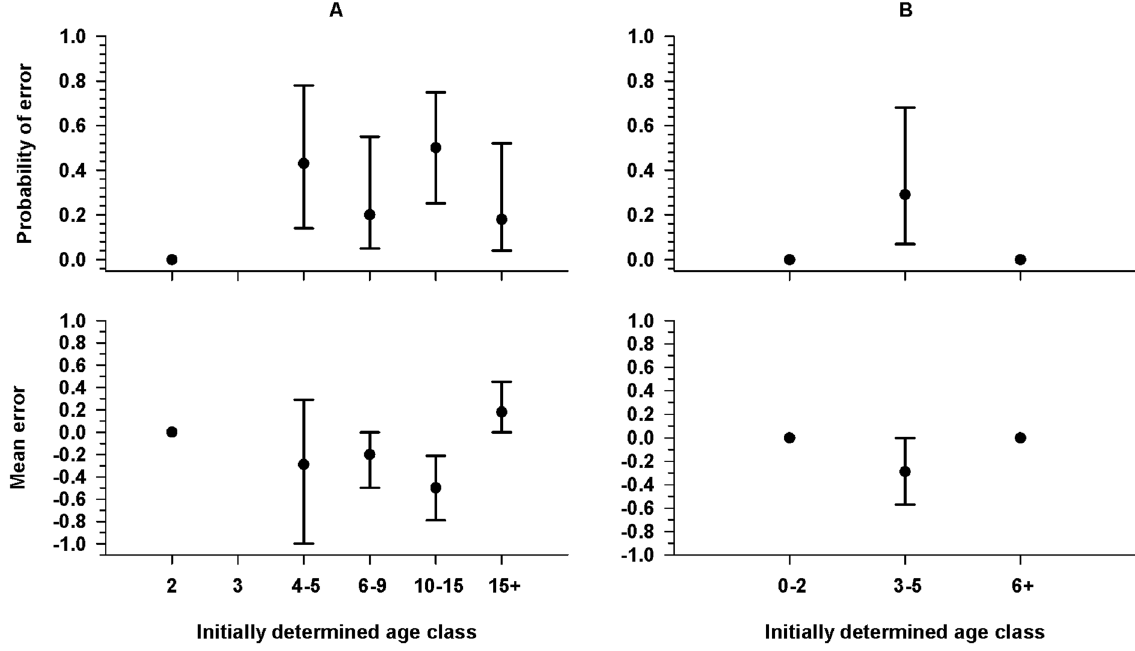
Figure 5. Probability of an error and mean size of the error in measurement-based age classifications. Probability of error and mean size of error for the 8-category (A) and 3-category (B) measurement-based age classifications relative to a second ‘‘better’’ measurement-based classification of Pacific walruses hauled out on the northwest coast of Alaska in fall of 2010 and 2011. Measurement-based age classifications are not possible for 0- and 1-yr classes, because tusks are not visible from walruses in these age classes. Error bars indicate 95% confidence intervals.